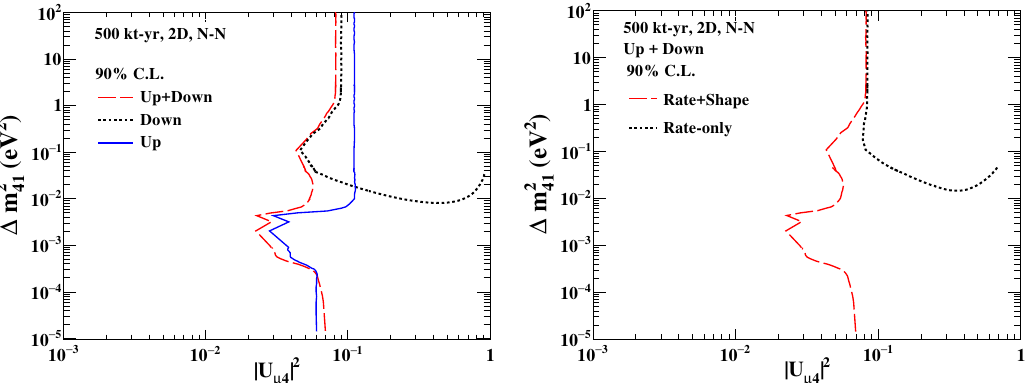
Figure 7 . Left panel: the e(cid:11)ect of a nonzero value of j U e 4 j on the 90% exclusion contours, for 500 kt-yr exposure. Right panel: the e(cid:11)ect of di(cid:11)erent mass ordering schemes on the sensitivity, for j U e 4 j = 0. The results have been presented for the N-N mass ordering scheme, and using only muon information.